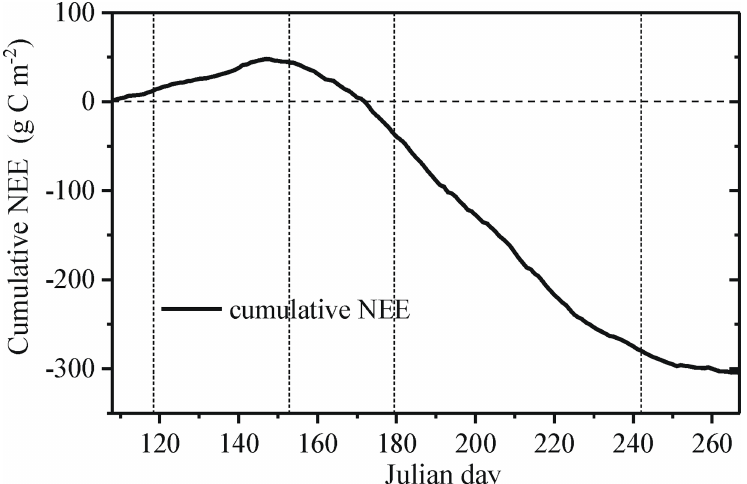
Fig 3. Cumulative time series of total daily NEE (net ecosystem exchange). The vertical dotted lines are the boundaries of different growing stages. The horizontal dotted line represents the zero reference.